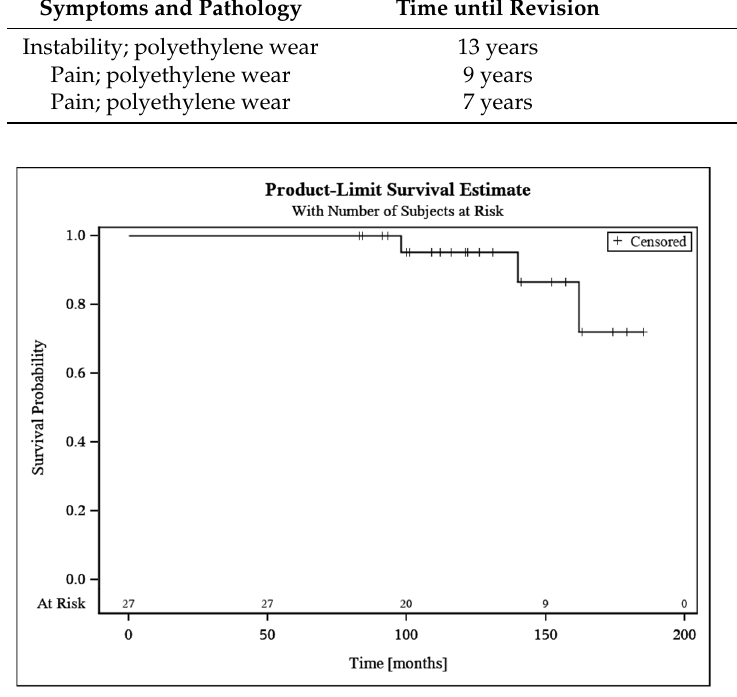
Figure 2. Survival